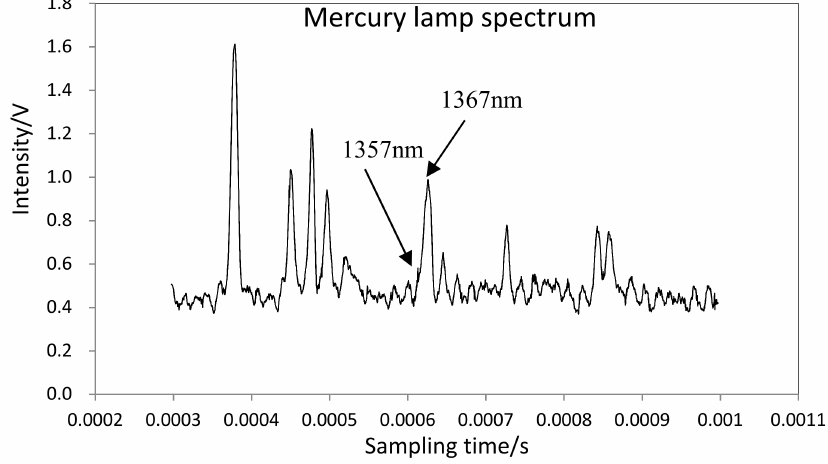
Figure 16. The resolution test curve of the micro-NIR